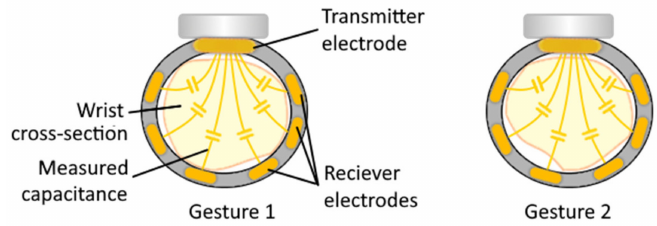
Figure 7. GestureWrist [122]—illustration of the principle. The device measures cross-sectional capacitances between each receiver electrode and transmitter electrode. The cross-section of the user’s wrist changes due to the change of hand